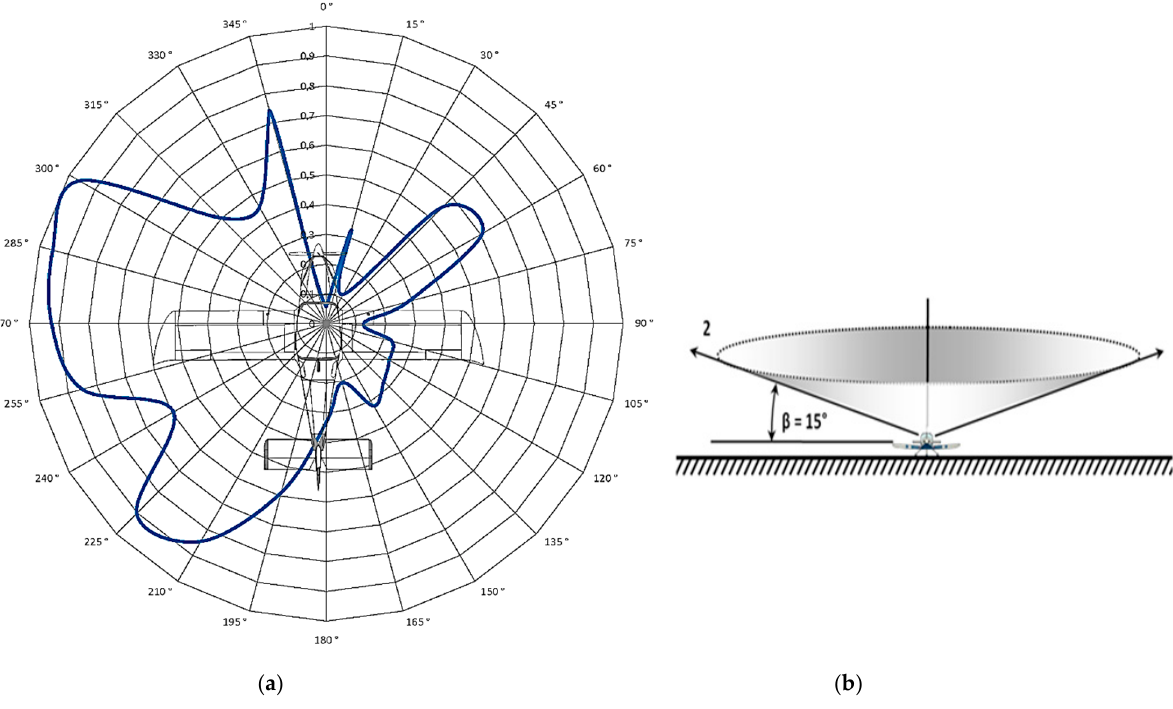
( b ) Figure 13. Measurement of the aircraft antenna characteristic at a position angle θ of 30°: ( a ) polar characteristics of the antenna; ( b ) spatial illustration of the measurement.